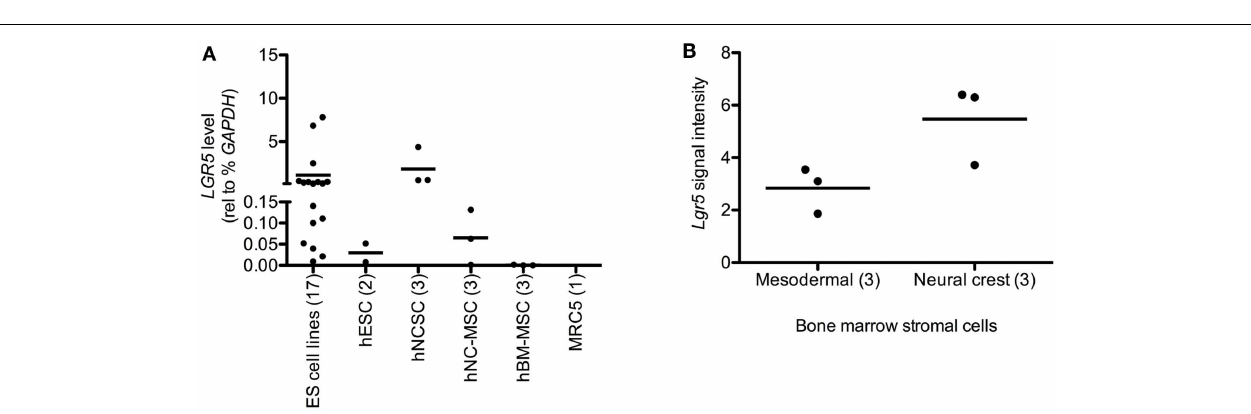
FIGURE 2 | Leucine-rich repeat-containing G-protein coupled receptor 5 is expressed by neural crest stem cells (NCSC). (A) qRT-PCR analysis of human embryonic stem cells (hESC), hESC-derived NCSC (hNCSC), hNCSC-derived mesenchymal stem cells (hNC-MSC), bone marrow-derived mesenchymal stem cells (hBM-MSC), and human lung embryo fibroblasts